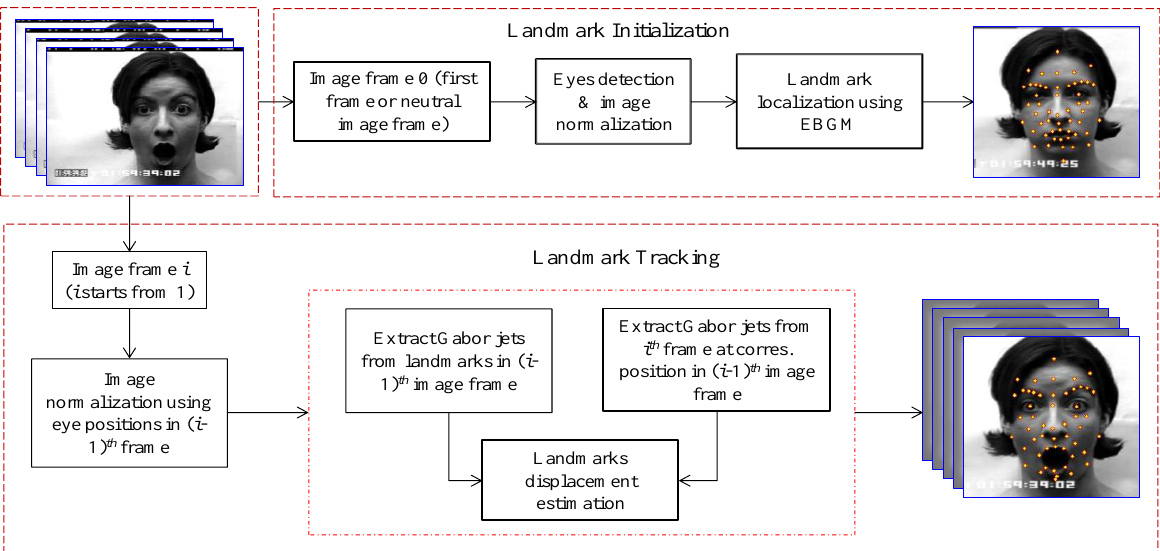
Figure 1. Overall block diagram of the landmark initialization and tracking